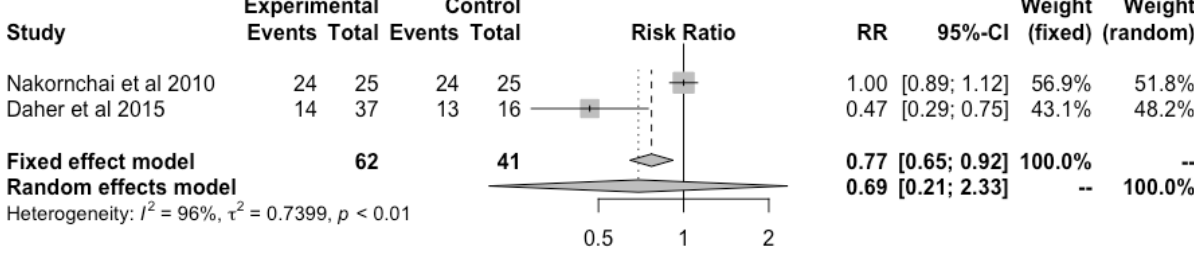
Figure 5. Meta-analyses of treatments for irreversible pulpitis and pulp necrosis comparing pulpectomy (control) with non- instrumented endodontic treatment